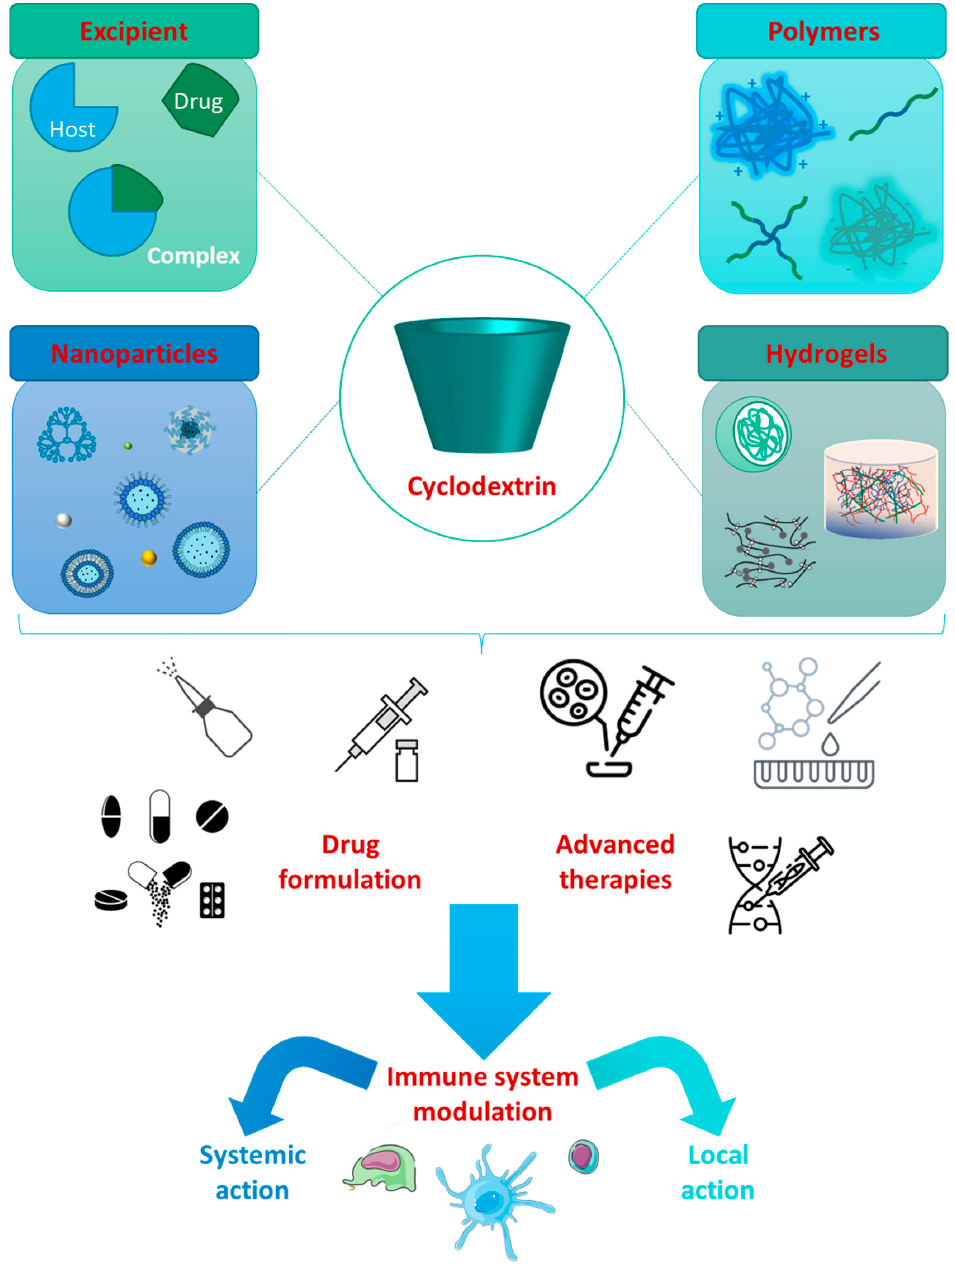
Figure 3. Cyclodextrins present versatile properties for formulating drug inclusion complexes and developing functional polymers, nanoparticles, and hydrogels. These cyclic oligosaccharides can promote the inclusion of therapeutic cargos, such as drugs, or advanced therapies, e.g., cells or genetic material, aiming for immunomodulatory outcomes by systemic or local action